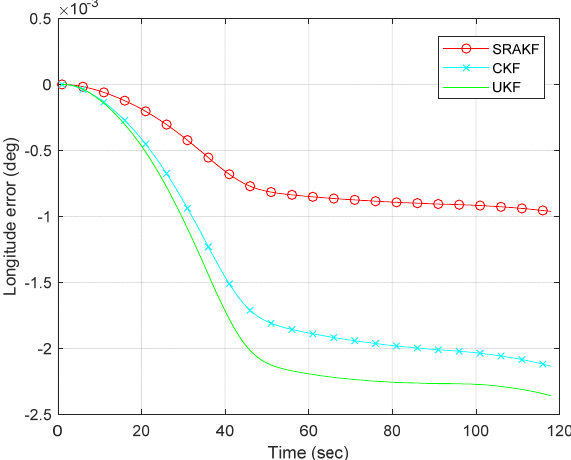
Figure 14. Longitude errors for the underwater lake trial.